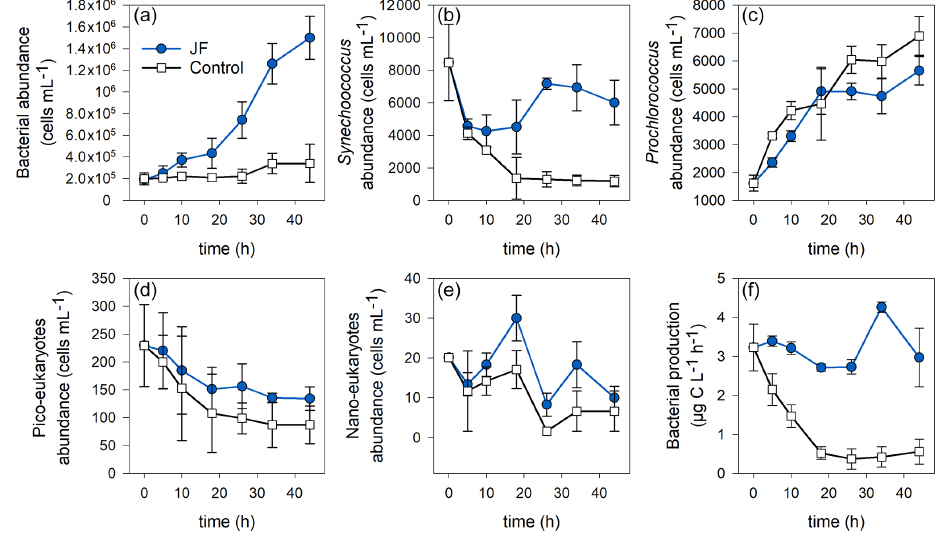
Figure 5. Microbial abundance (cellmL − 1 ) and production (µgCL − 1 h − 1 ) in the jellyfish R. nomadica -enriched (blue) and control (black) experimental cylinders over the experimental period: (a) total bacterial abundance, (b) Synechococcus , (c) Prochlorococcus , (d) picoeukary- otes, (e) nanoeukaryotes, and (f) bacterial production. N = 3, the error bars denote standard deviation.